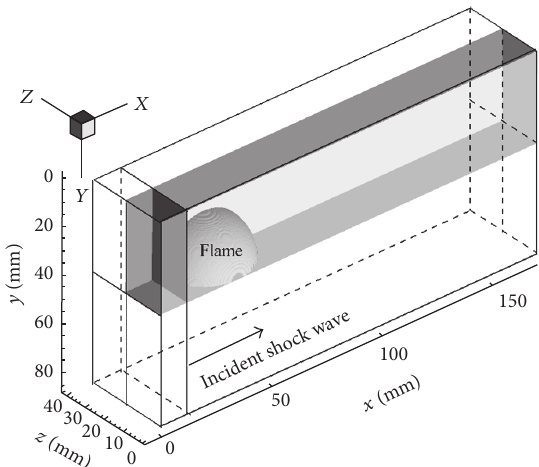
Figure 2: Schematic of three-dimensional computational